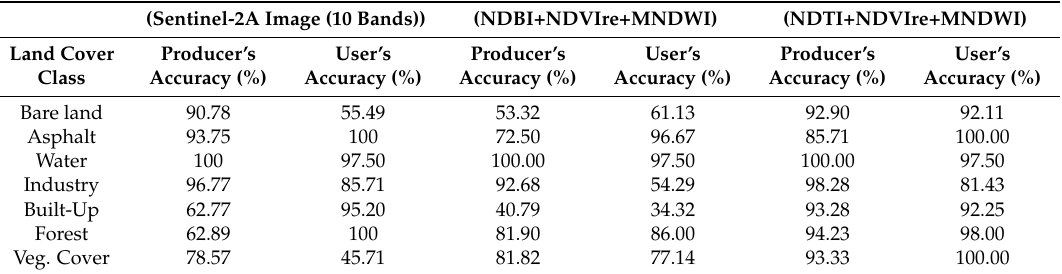
Table 4. Classification accuracies of the different approaches for the Istanbul region.